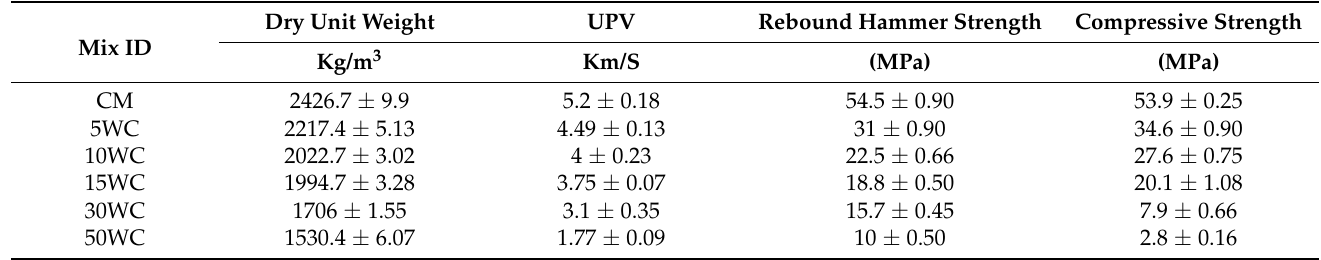
Table 4. The results of destructive and non-destructive tests for different